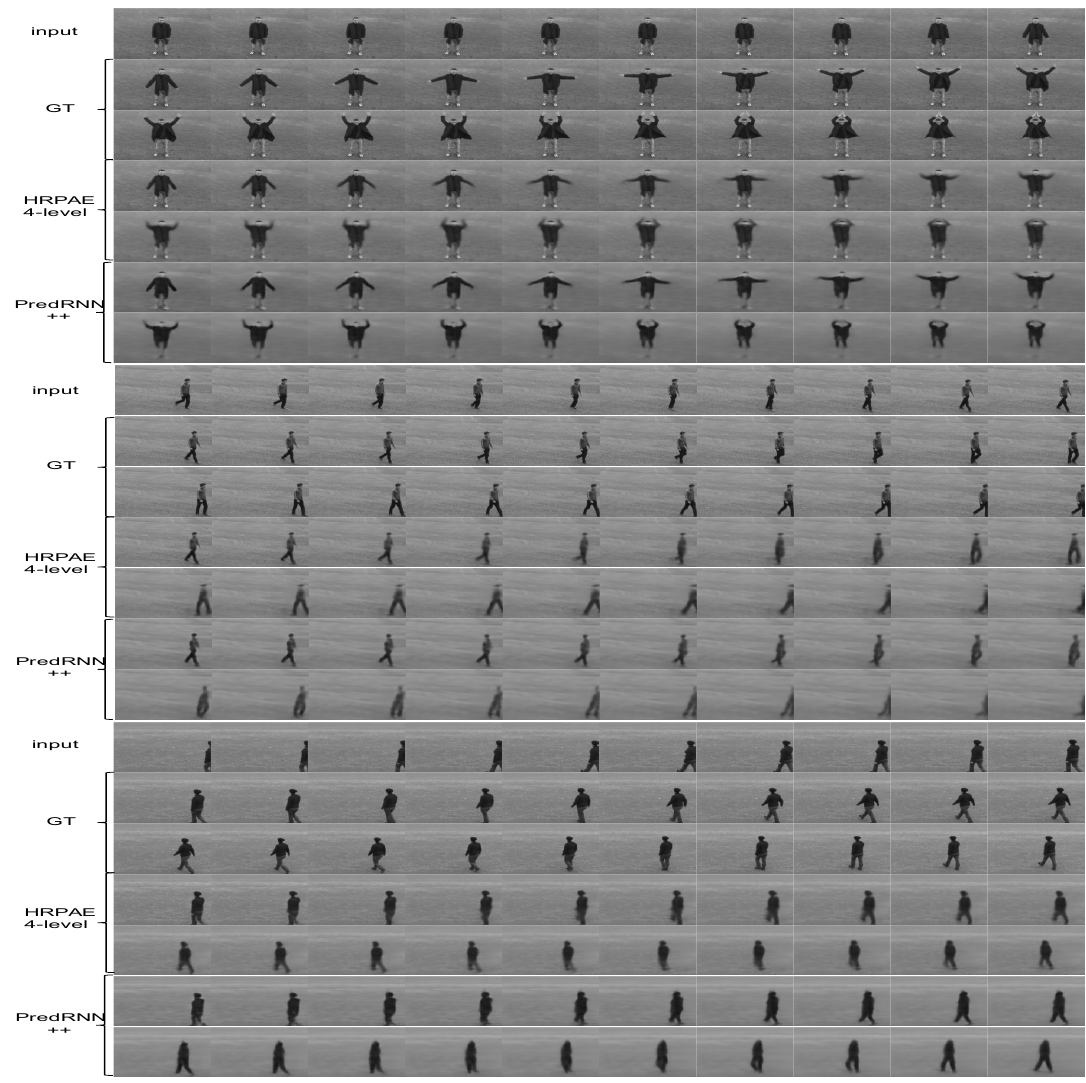
Figure 7. Qualitative KTH prediction